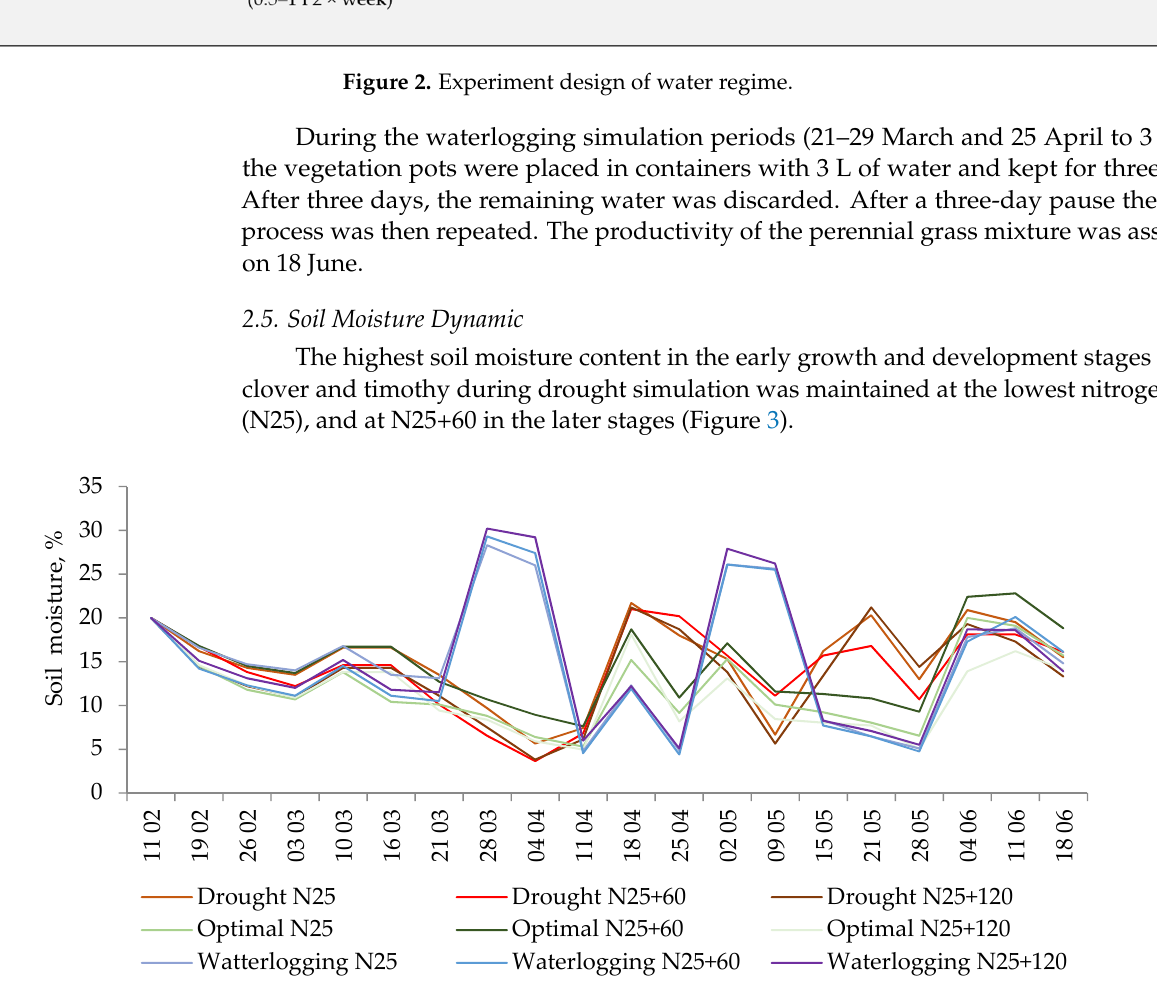
Figure 3. Soil moisture dynamic during vegetative experiment.